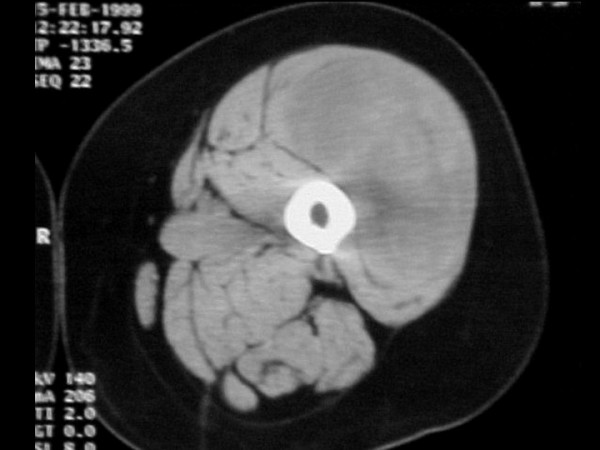
Computed tomography scan of the left thigh shows a large soft tissue mass involving the vastus lateralis muscle.